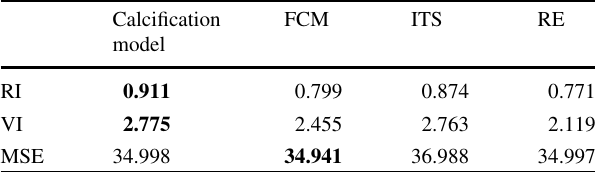
Table 3 Calcification model evaluation procedure of the first clinical expert Calcification model